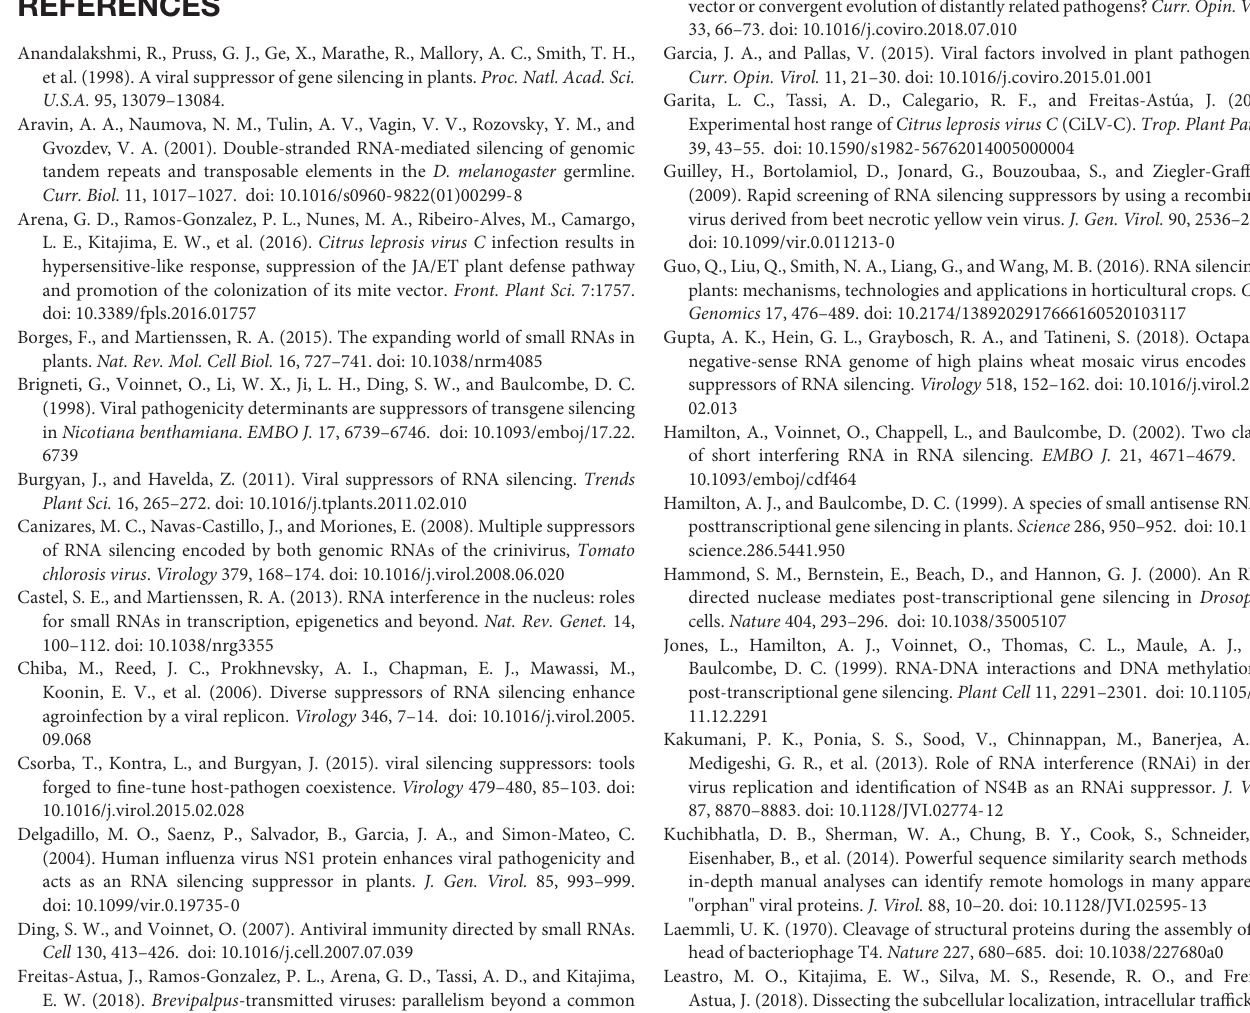
GFP:HA/MP/CP AMV RNA 3, in which the open reading frames correspond to the green fluorescent protein (GFP), the movement protein (MP) and the coat protein (CP) are represented by large boxes. In the assayed AMV constructs the GFP gene is changed with the different p61 indicated versions. Necrotic response observed at 4 dpi. Arrows represent subgenomic promoters and doted circles delimited the inoculated leaf area. Three independent experiments were performed, each one included the infiltration of three leaves per plants and three plants per construct. FIGURE S2 | The CiLV-C p15 does not complement movement of the TCV (cid:49) 92-sGFP mutant. N. benthamiana leave were infiltrated with pMOG 800 expressing the HCPro and CiLV-C MP and p15 proteins. Infectious RNA transcript of the TCV (cid:49) 92-sGFP construct were mechanically inoculated one day post agroinfiltration. Cell-to-cell movement evaluated at 3 dpi. White bars correspond to 0.5–2 mm. FIGURE S3 | RT- PCR analysis to confirm the genetic stability of the PVX constructs expressing the CiLV-C p29 (792 bp), p15 (393 bp), p61 (1614 bp), MP (894 bp) and p24 (645 bp) proteins. RT-PCR performed from upper leaves of N. benthamiana plants infected at 14 dpi using specific primers for each gene. C+, RT-PCR from N. benthamiama leaves transiently expressing the HCPro (positive control); C − , RT-PCR from uninfected plant sample. The marker band size of 300, 650, 1,000, and 1,500 bp are indicated. M, 1 kb DNA ladder.